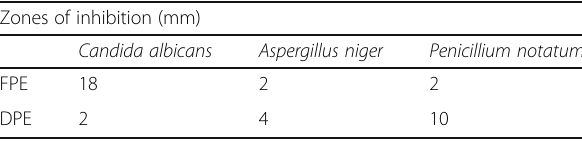
Table 2 Antifungal activities of Citrus sinensis peel extracts (200 μ g/mL) against some bacterial strains tested by disc diffusion assay Zones of inhibition (mm) Candida